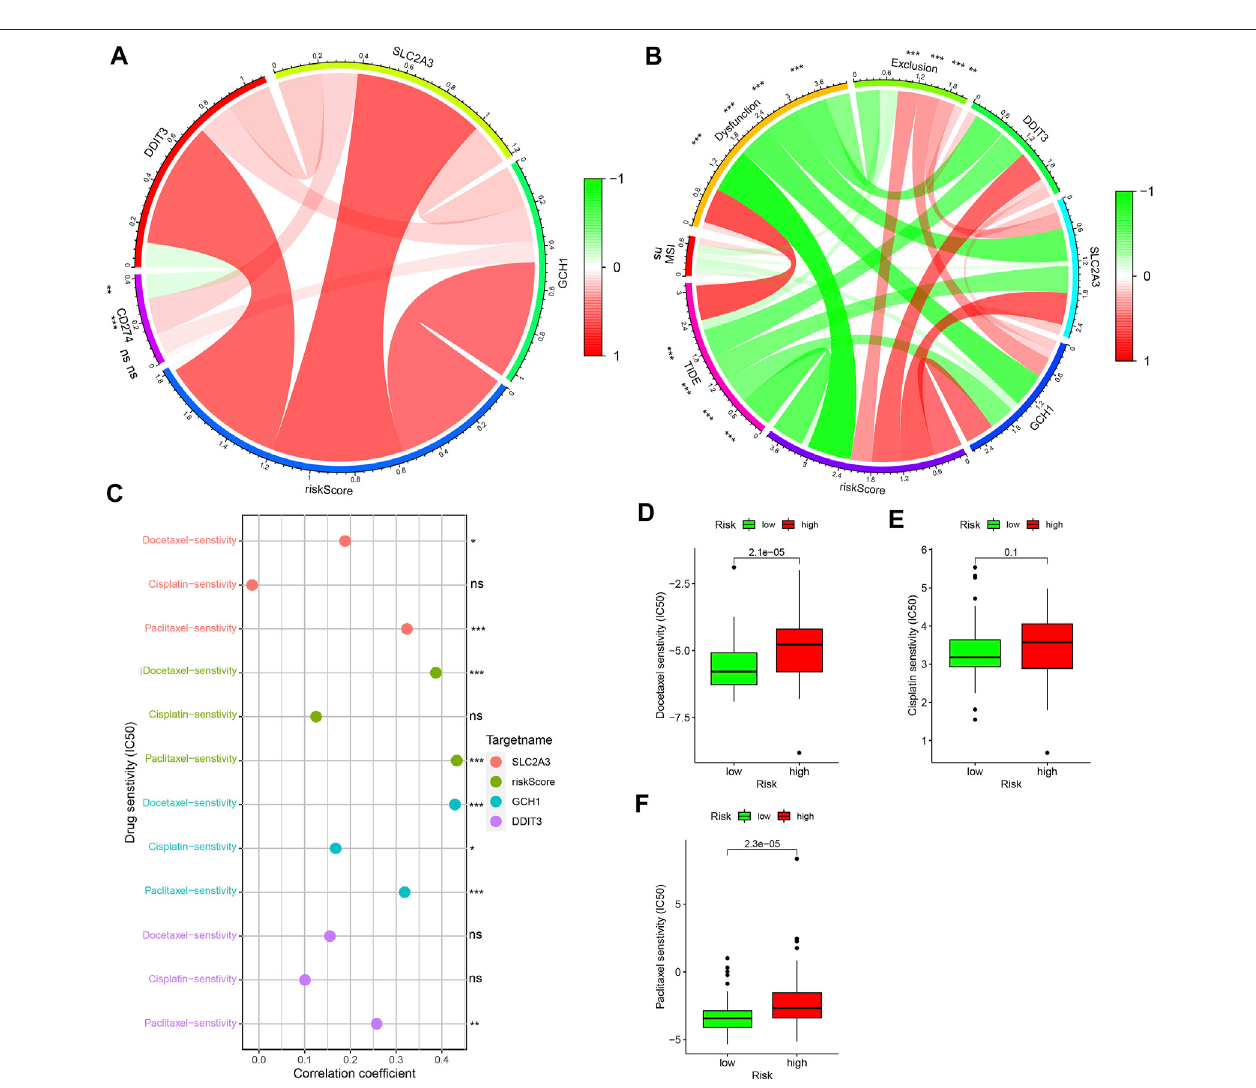
FIGURE 11 | Application of model to clinical treatments. (A) Correlations among gene expression levels of three PR-DE-IRFeGs, CD274, and their risk score. (B) Correlations among gene expresion levels of three PR-DE-IRFeGs, scores for TIDE, MSI, Dysfunction, Exclusion, and risk scores. (C) Correlation between the three drugs in clinical use and expression level of three PR-DE-IRFeGs, risk score. (D – F) Drug sensitivity of docetaxel, cisplatin, and paclitaxel for the high and low-risk groups.